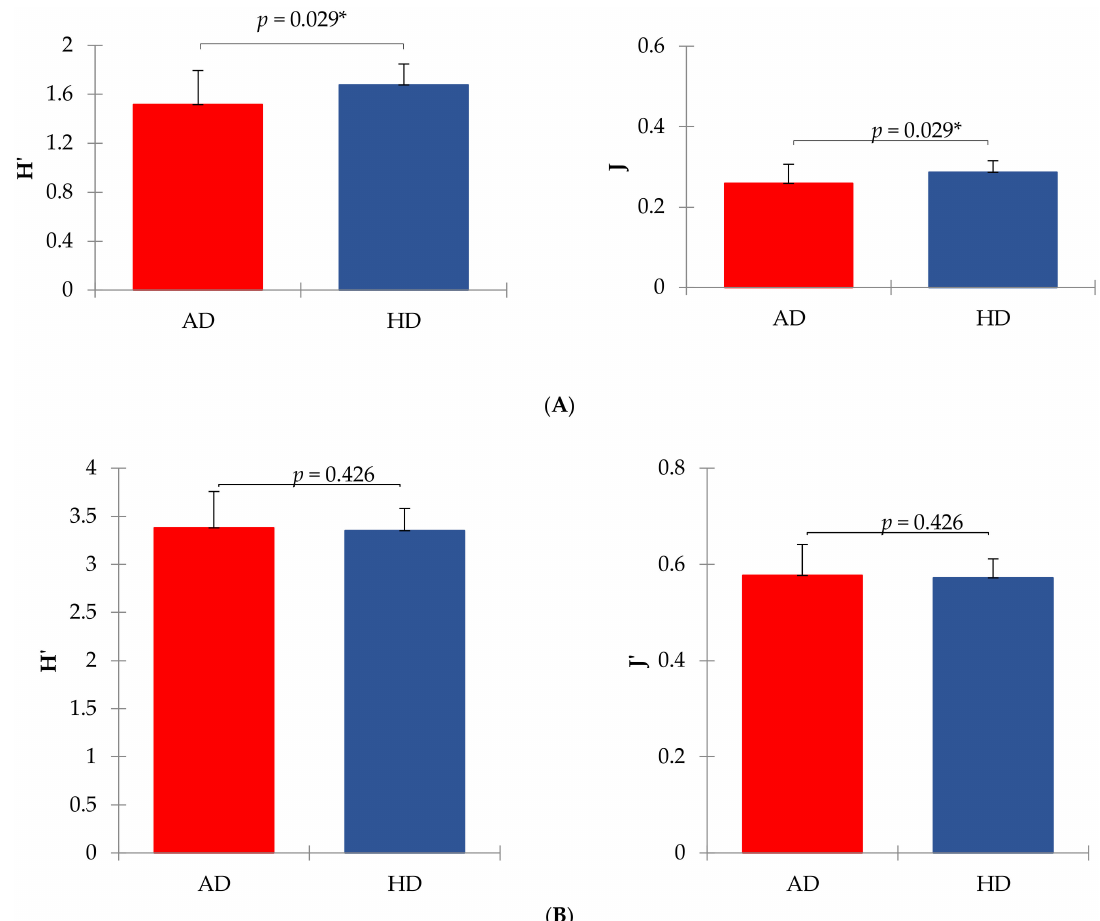
Figure 1. Shannon (H’) and Evenness (J’) indexes of diversity in arthritic (AD) and healthy (HD) dogs. Panel ( A ) shows mean values at the family level (means were significantly di ff erent for p < 0.05 between AD and HD groups). Panel ( B ) shows mean values at the genus level (means were not significantly di ff erent between AD and HD groups). Shannon index was calculated according to the equation H’ = − sum (Pi × ln Pi), where Pi = frequency of every taxon within the sample. The evenness index was calculated as J’ = H’ / ln S, where S = total number of taxa within each